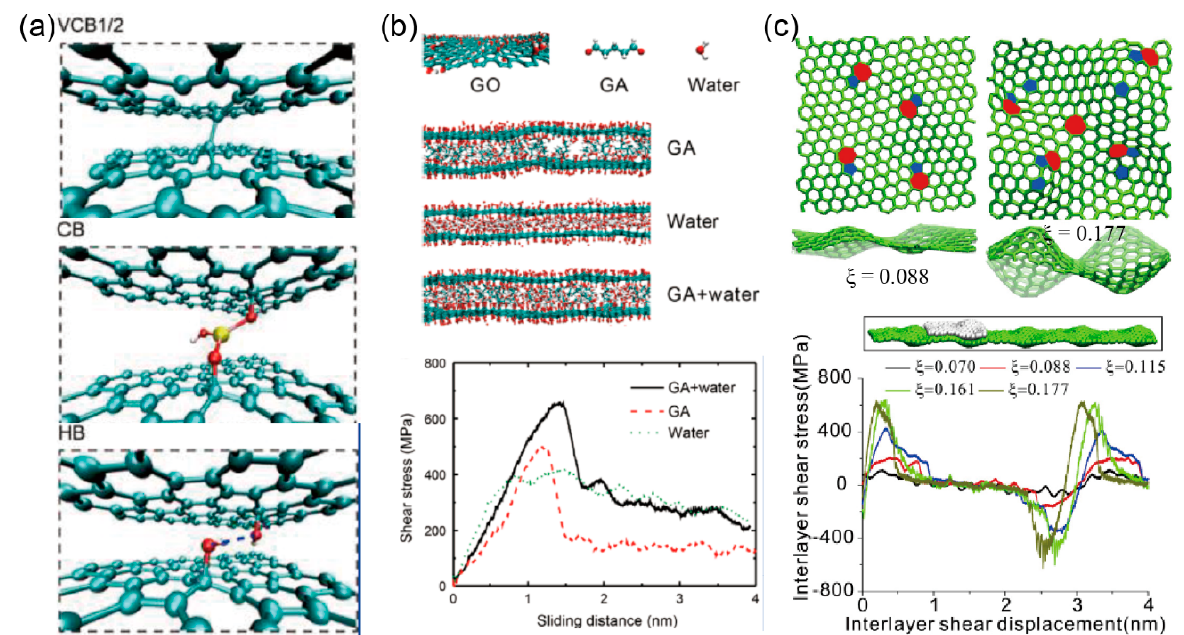
Figure 8. ( a ) Interlayer crosslinks including covalent (VCB1/2) and non ‐ covalent (CB and HB) bonds. Reprinted with per ‐ mission from [119]. Interlayer crosslinks ( b ) and geometrical locking ( c ) can improve the in ‐ plane shear properties of mul ‐ tilayer graphene. Reprinted with permission from [22,120].